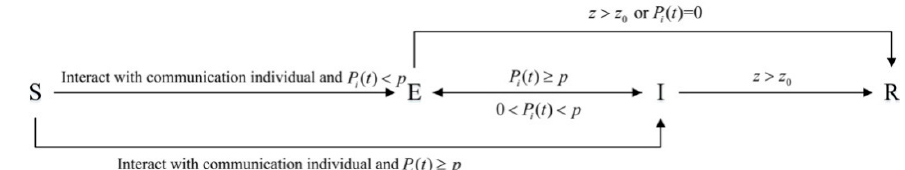
Figure 2. Individual state transition rules in the improved SEIR model.